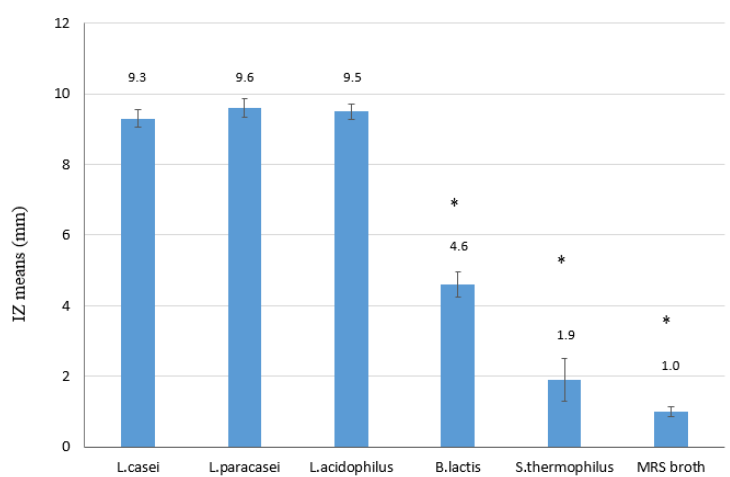
Figure 1. Inhibition zone (IZ) means of the five probiotic strains against H. pylori . DeMan-Rogosa-Sharpe (MRS) and Brain Heart Infusion (BHI) broths were used as negative controls. BHI broth never produced an IZ. IZs trend: L. casei = L. paracasei = L. acidophilus > B. lactis > S. thermophiles > negative control. * p < 0.05 was considered significant. No differences were observed in the IZ means of the same probiotic strain vs. the eight H. pylori groups. This confirms that H. pylori antibiotic resistance mechanisms do not interfere with its susceptibility to the antimicrobial activity of probiotic strains (Figure 2).